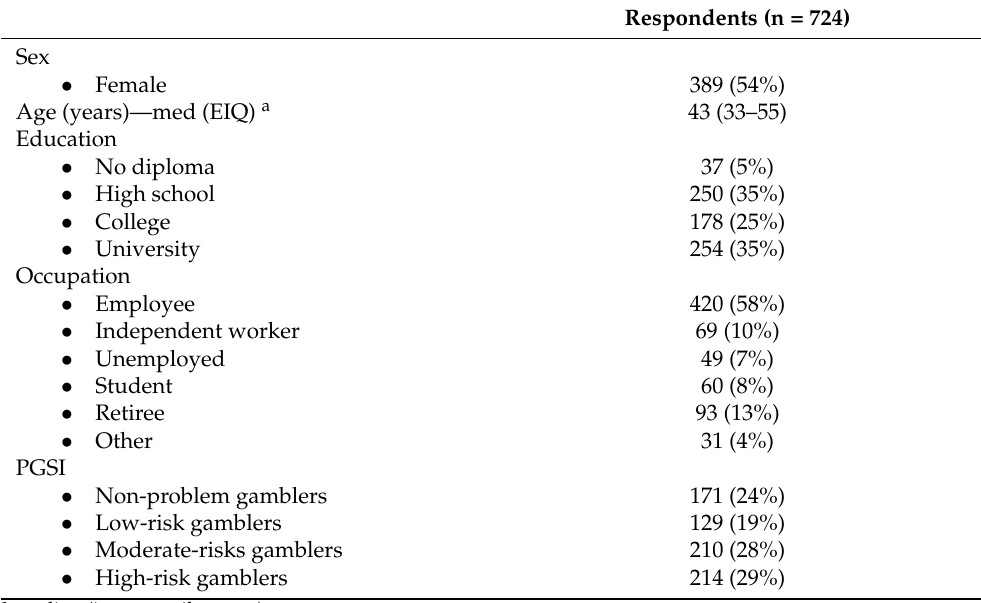
Table 1. Sociodemographic portrait of participants.